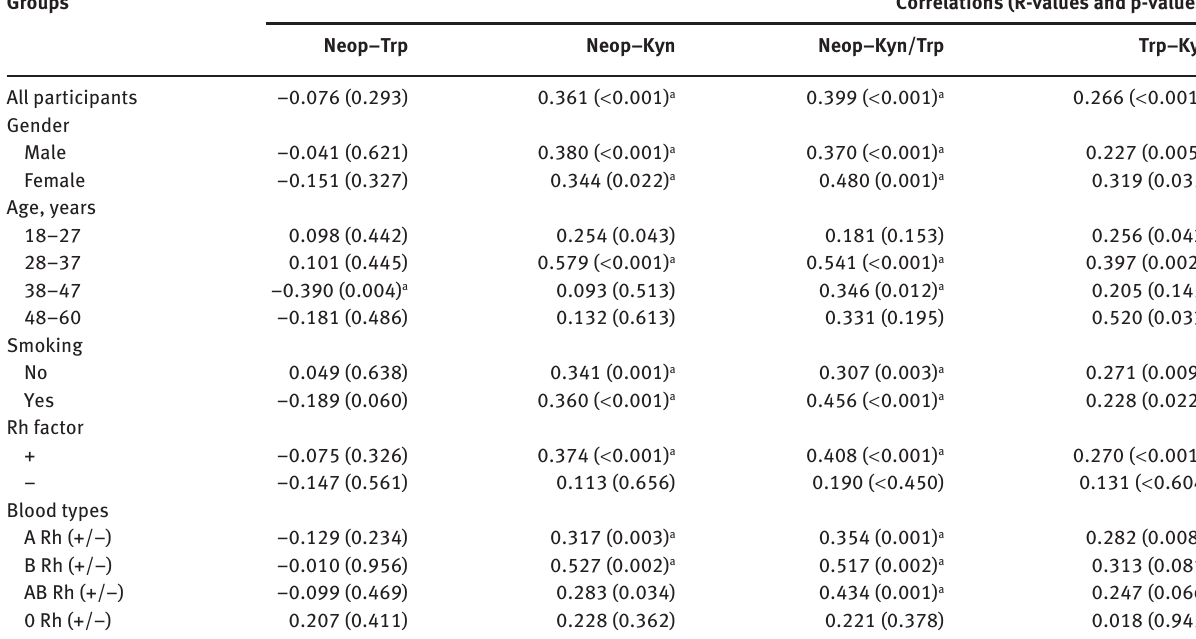
Table 2 Correlations between measured parameters in blood donors (total, n =